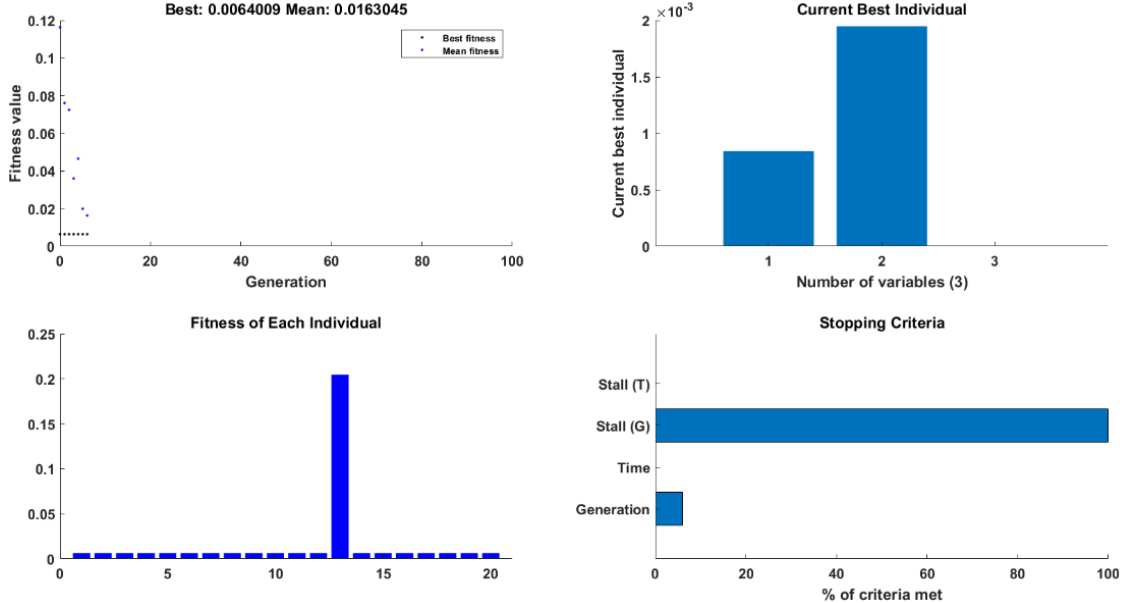
Figure 8. The testing GA for optimizing the reflectivity and bandwidth.